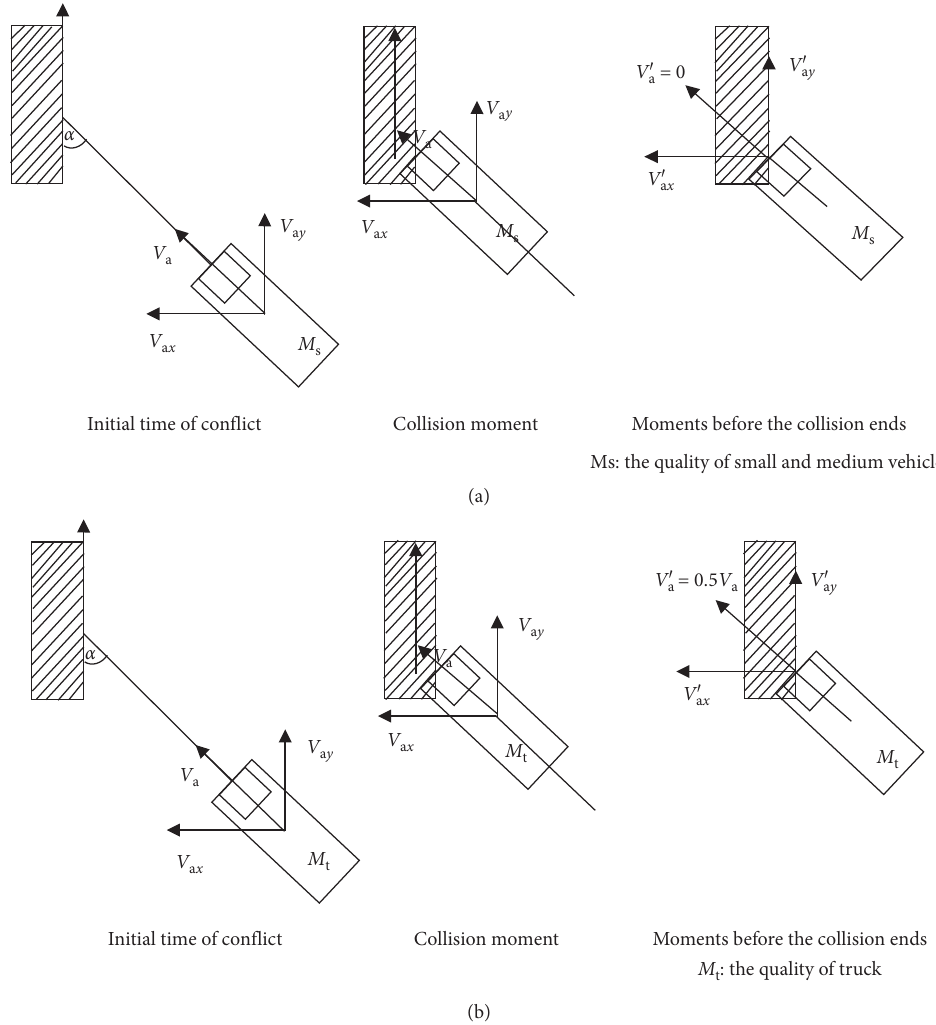
Figure 2: Schematic diagram of collision between vehicle and road facility (two